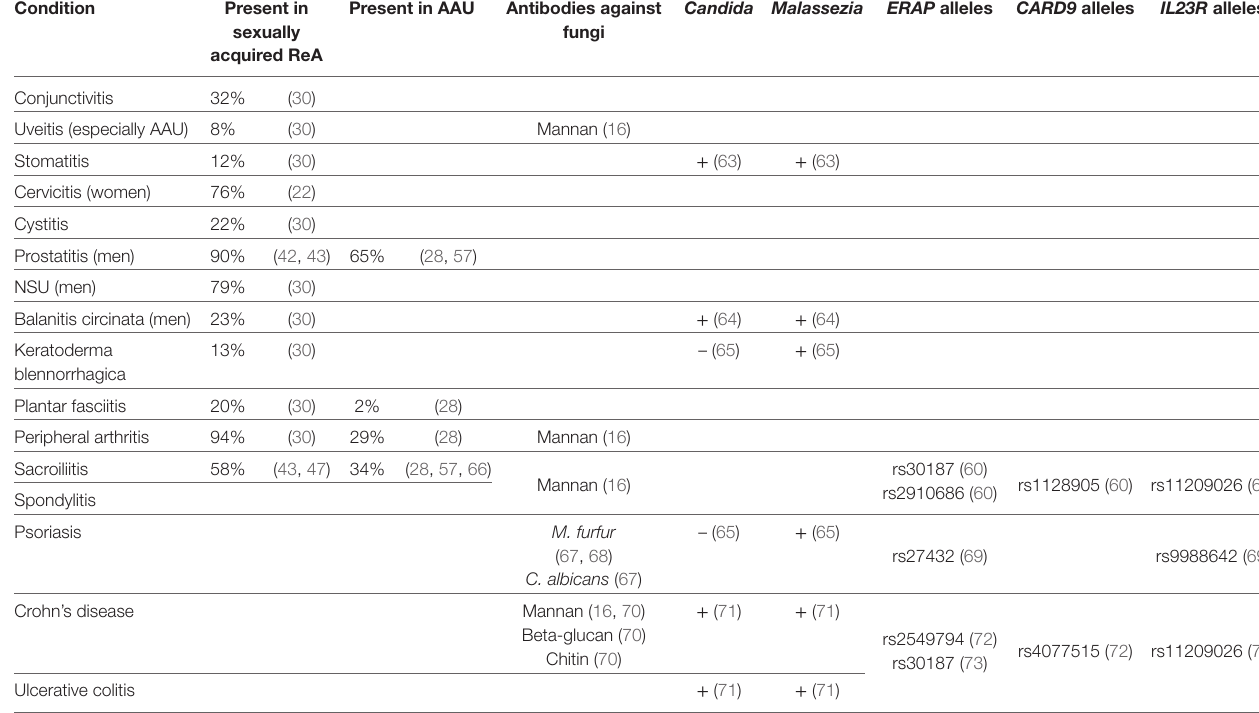
table 3 | Conditions associated with HLA-B*27